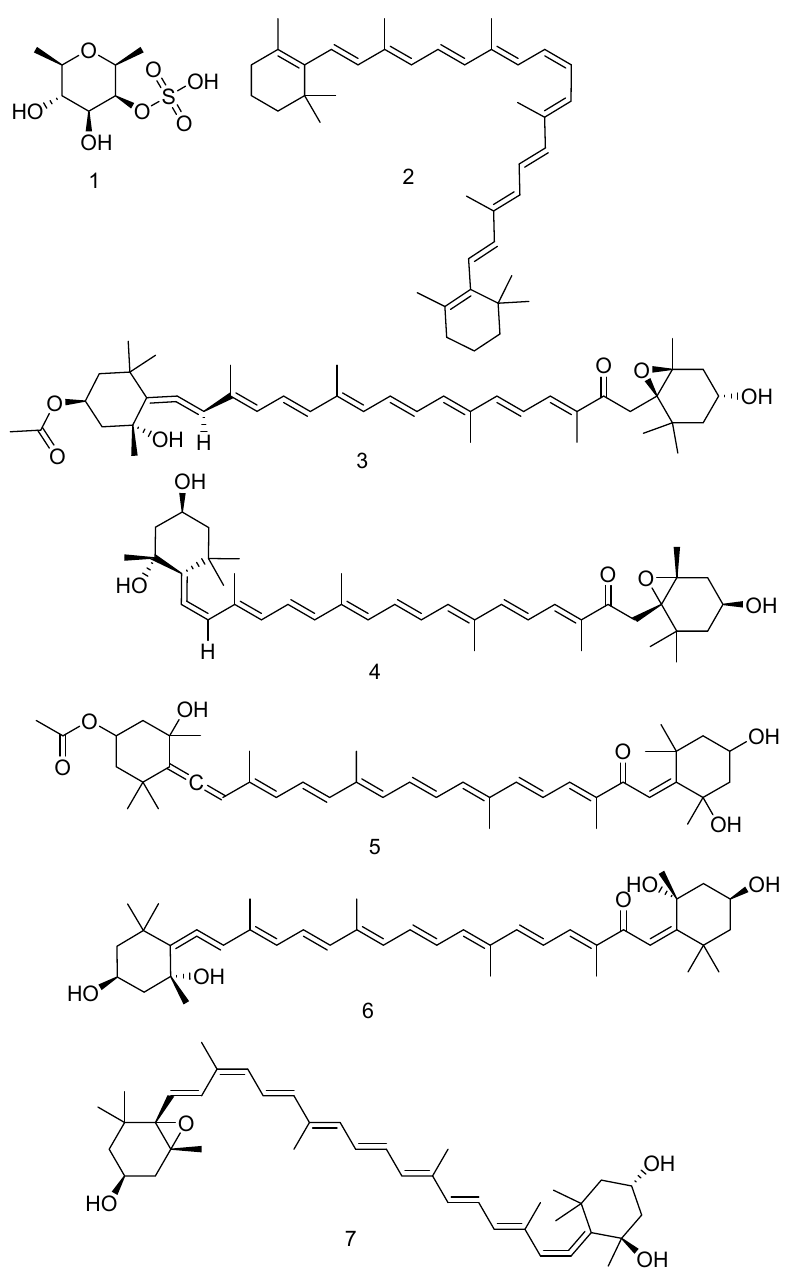
Figure 6. Compounds from 1 – 7 (The fucoidan and several carotenoids).